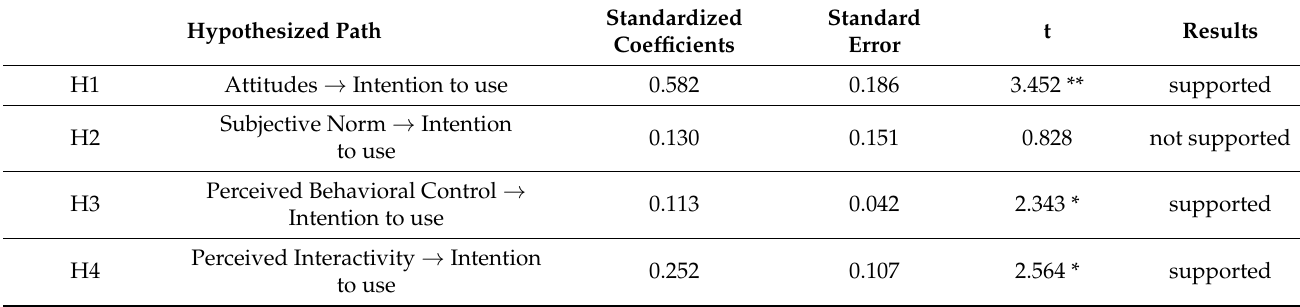
Table 4. Summary of tested